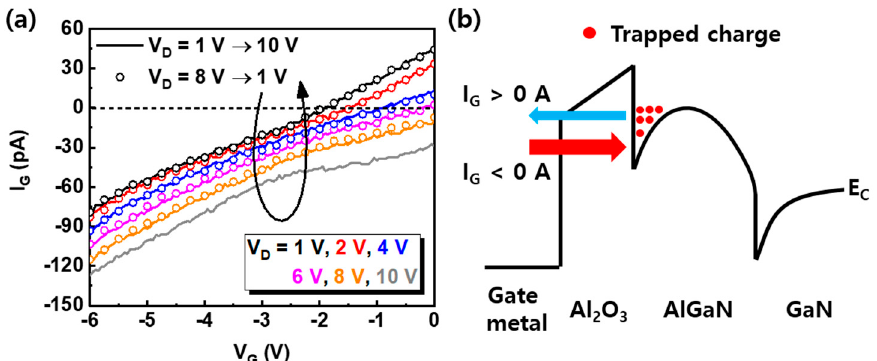
Figure 4. ( a ) The gate leakage current of the 7-nm recess + CF 4 device for various V D . The solid lines and open circles reflect the increase in V D and decrease of V D , respectively. ( b ) The band diagram of the 7-nm recess + CF 4 device. The blue and red arrows indicate the flow of gate current. The trapped charges at the dielectric / AlGaN interface reduce by positive gate current (V D < 5 V) and the trapped charges increase by negative gate current (V D > 5 V).